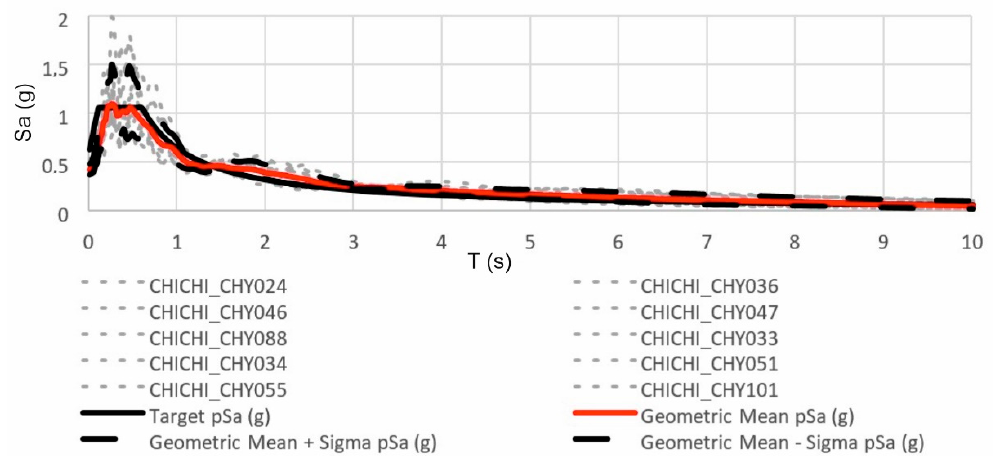
Figure 7. Elastic seismic spectra Acceleration response spectrum (5% structural damping) for ten scaled seismic movements (gray lines) for inverse component earthquakes, with seismological characteristics similar to the expected uniform hazard spectrum, 10% probability of exceedance in 50 years, the median and median ± 1 standard deviation of the scaled movements for NEC-type rock profile.